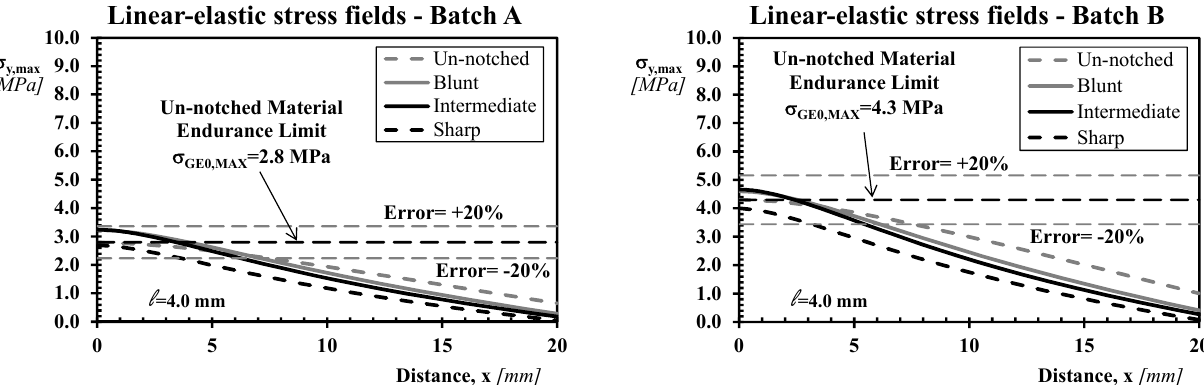
Figure 5: Accuracy of GE applied by taking l equal to the average inter-aggregate distance ( l = 4